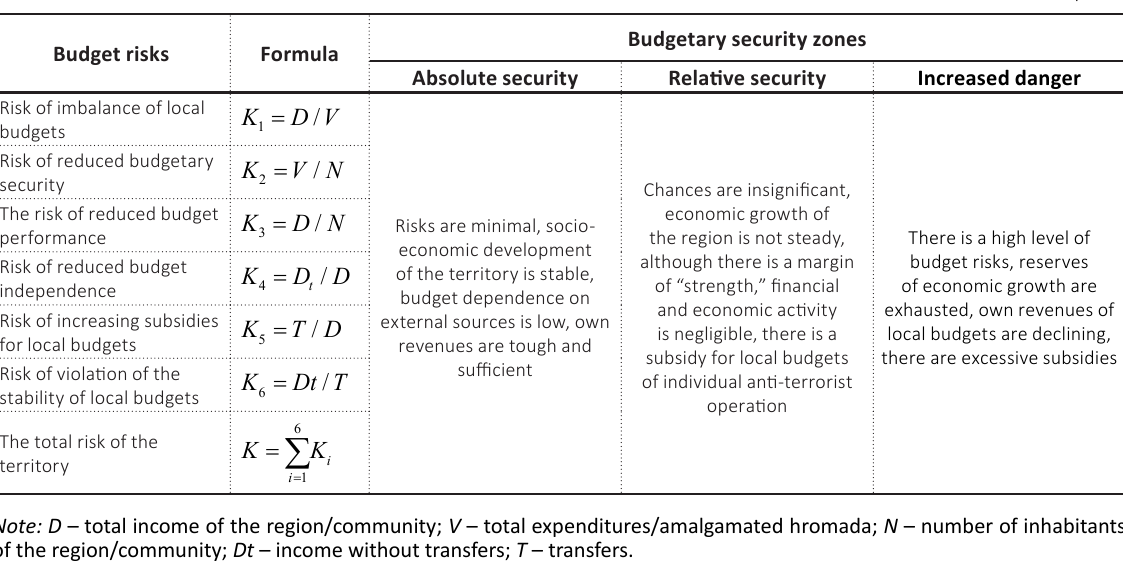
Table 3. Limit values of budget risks: regions and amalgamated hromada